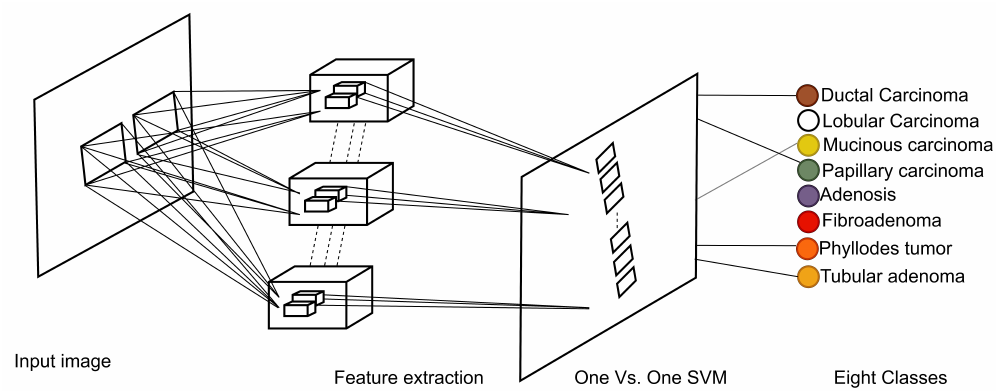
Figure 11. Proposed multi-scale pooled image feature representation (MPIFR) approach for multi- class classification of breast